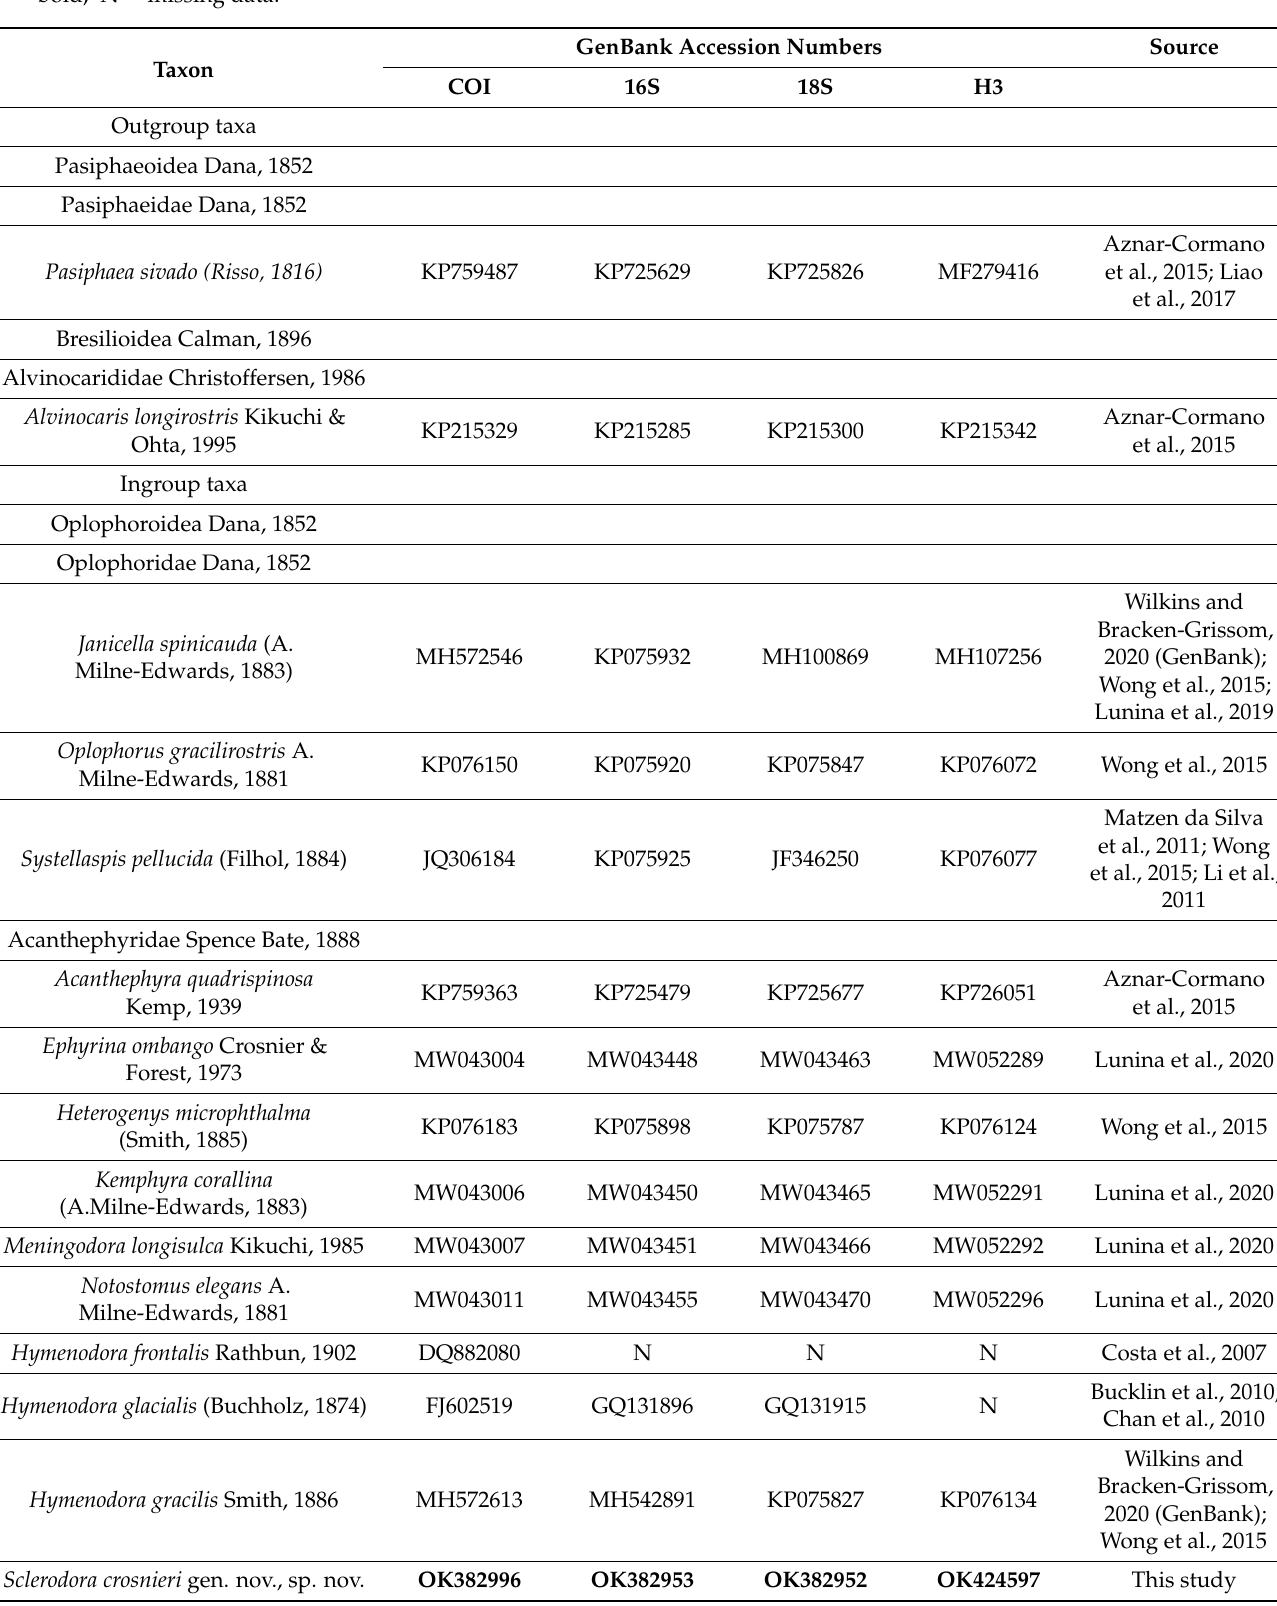
Table 2. Details of the analyzed species and sequences used in the study. Newly retrieved sequences are highlighted in bold; ‘N’—missing